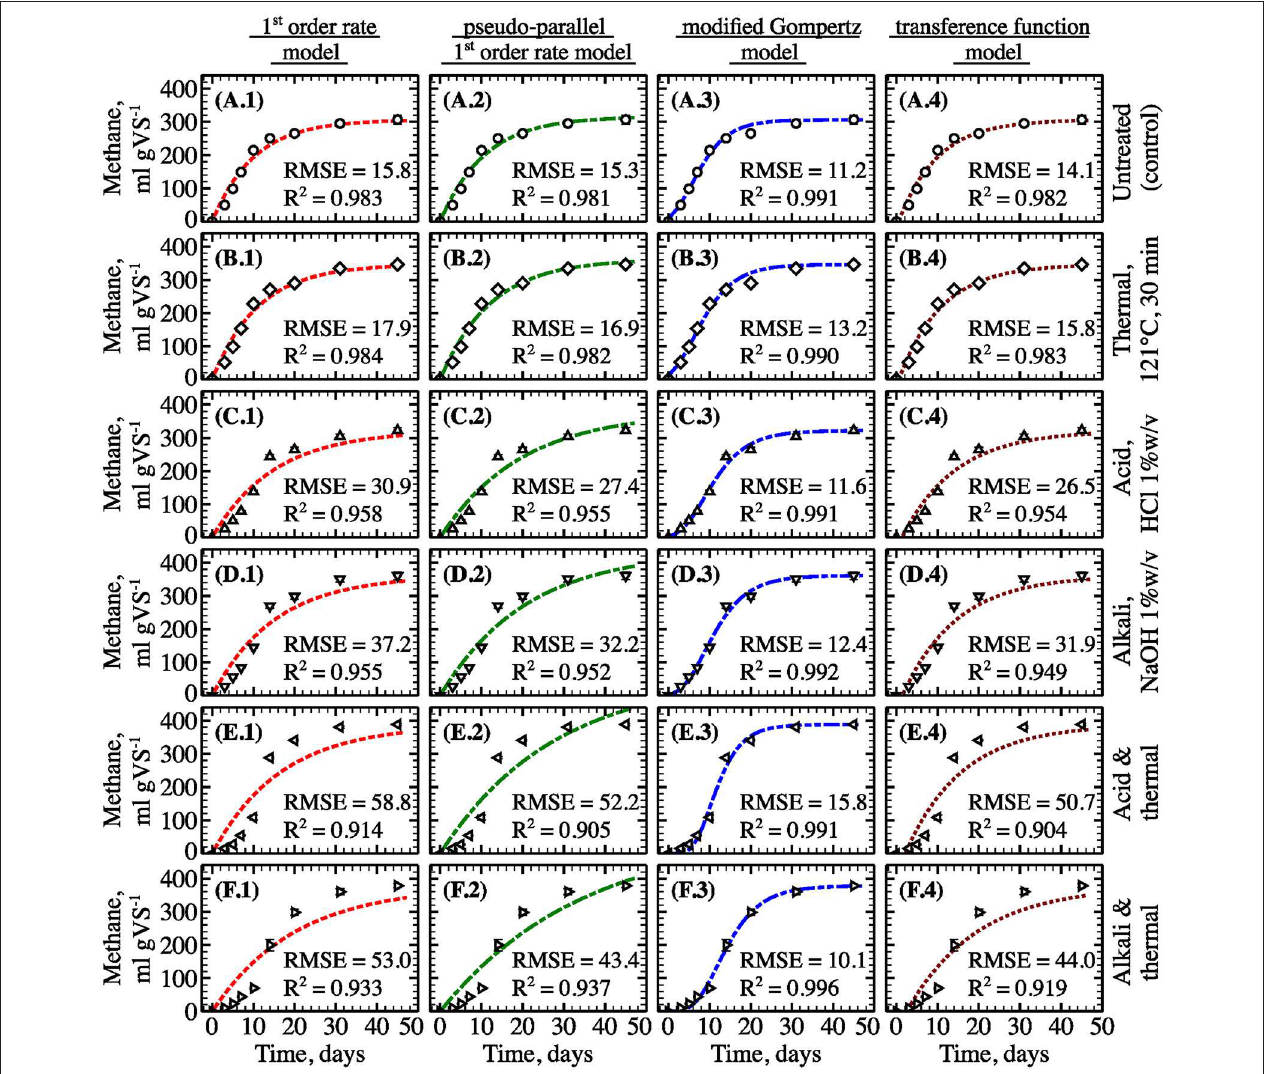
FIGURE 5 | Experimental and predicted specific methane yield from untreated filamentous algal biomass (A) and biomass pretreated using thermal (B) , acid (C) , alkali (D) , thermochemical with acid (E) and thermochemical with alkali (F) methods (points—experimental data; lines—model fit, type of the model is specified on top; pretreatment conditions are specified on the right; error bars represent 1 S.D. for three